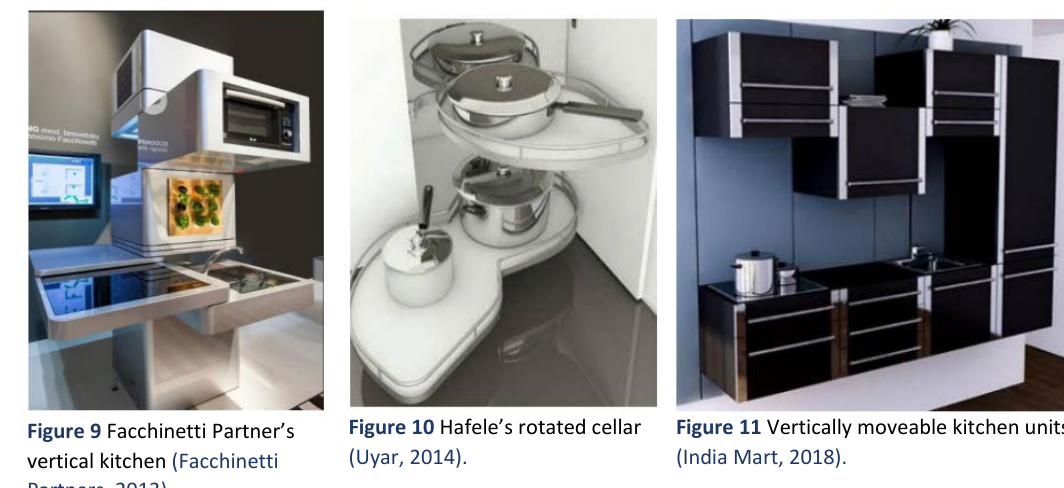
Figure 10 Hafele’s rotated cellar (Uyar, 2014).